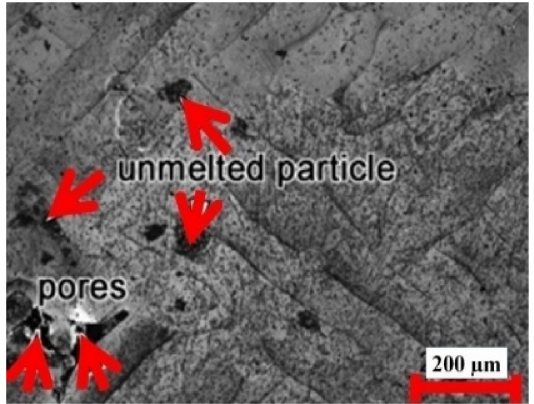
Figure 9. Pores and unmelted particles in the SLM processed Ti-24Nb-4Zr-8Sn